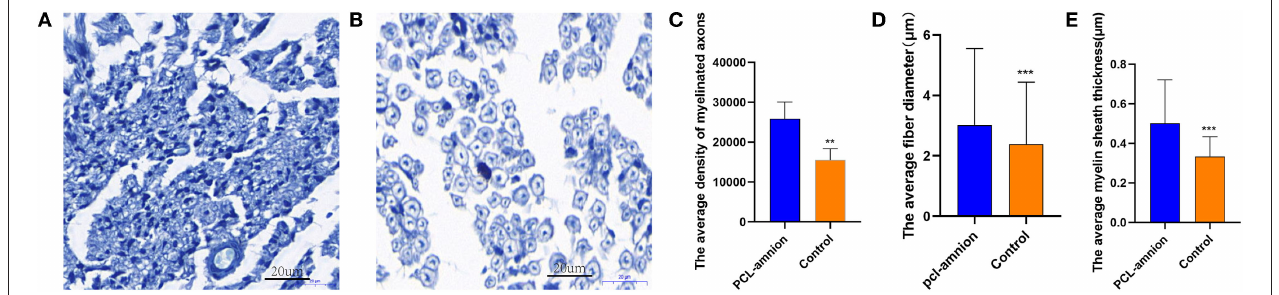
FIGURE 4 | Histomorphometry analysis of nerve regeneration. (A) The PCL-amnion nanofibrous membrane group. (B) The Control group. (C–E) More mature fibers were observed in the PCL-amnion nanofibrous membrane group. (C) The average density of myelinated axons was significantly different between two groups ( P < 0.05). (D) The average fiber diameter of myelinated nerve fibers was significantly different between two groups ( P < 0.05). (E) The average myelin sheath thickness of the sciatic nerve was significantly different between two groups ( P < 0.05). *** P < 0.01 compared to the PCL-amnion group. ** P < 0.001 compared to the PCL-amnion group.